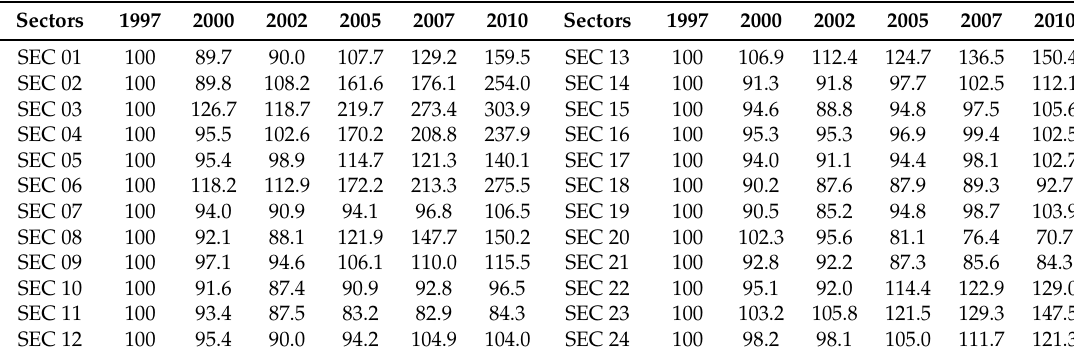
Table A1. The price indexes in all